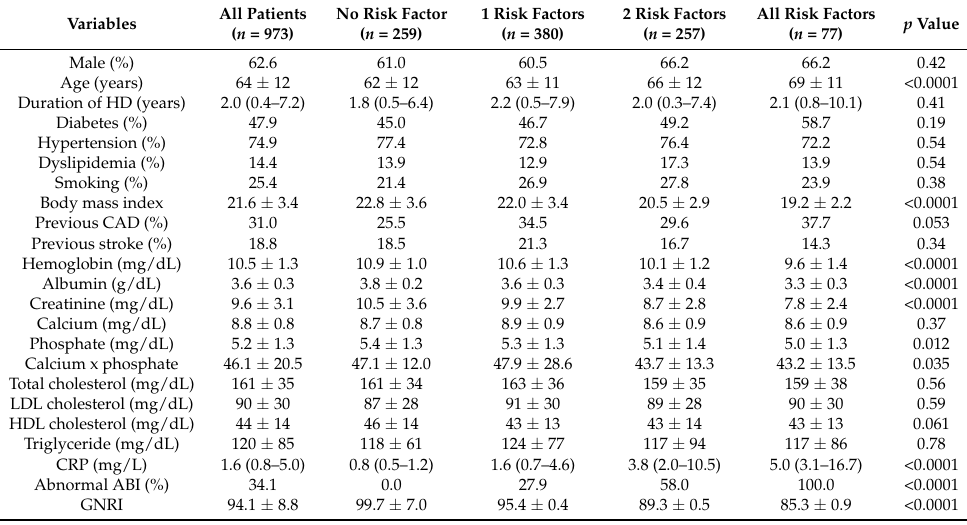
Table 1. Baseline patient characteristics in relation to presence of three risk factors: abnormal